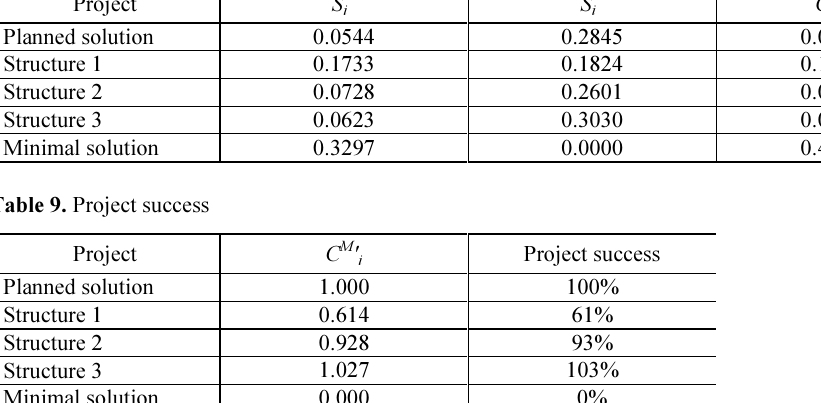
Table 8. Calculation of the relative proximity of alternatives from the ideal solution Project